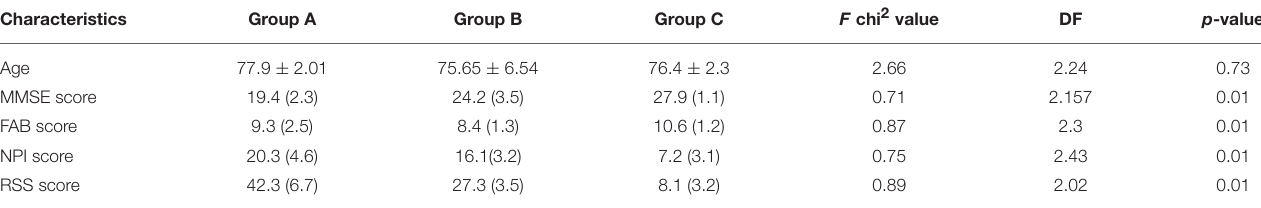
TABLE 1 | Neuropsychological characteristics of study population (mean and SD in brackets). Characteristics